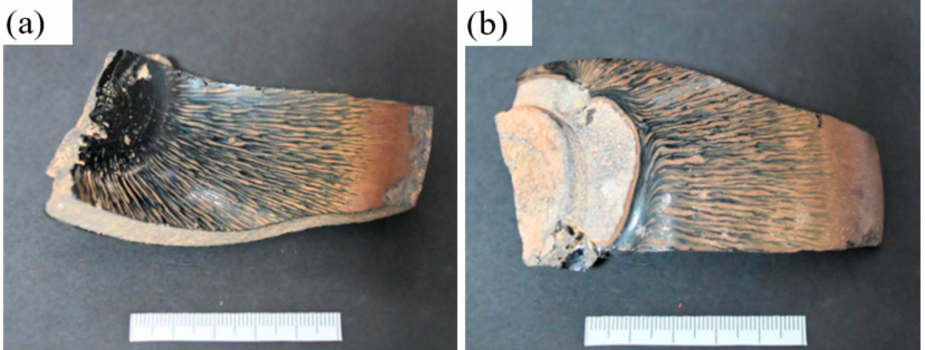
Figure 1. ( a ) Top and ( b ) bottom views of the hare’s fur Jian ware in Fujian Province,